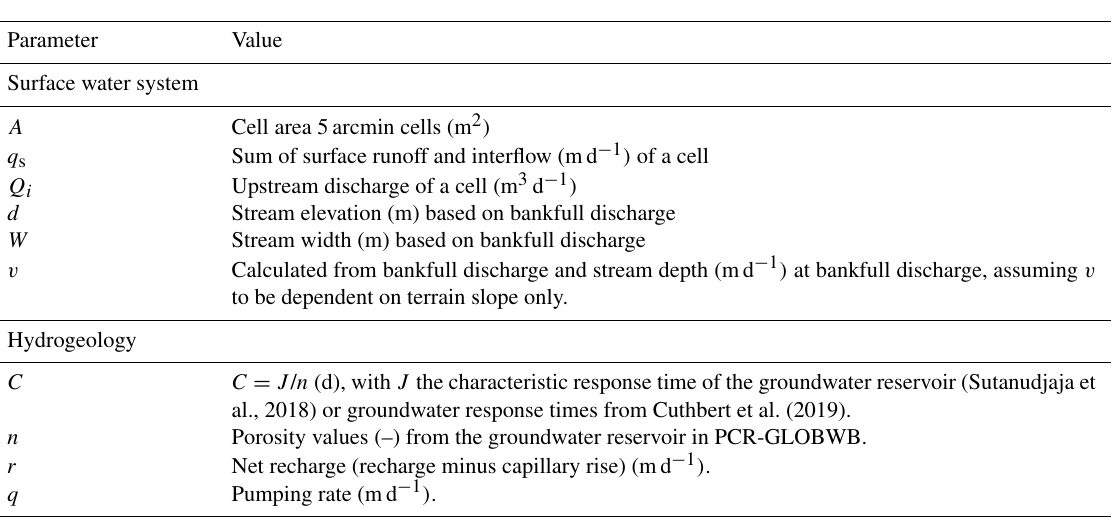
Table 3. Parameter and input values used in global-scale analyses at 5arcmin cells ( ∼ 10km at the Equator). All inputs obtained from PCR- GLOBWB 2 (Sutanudjaja et al., 2018), except the C values obtained from PCR-GLOBWB and from Cuthbert et al. (2018); input variables averaged over the period